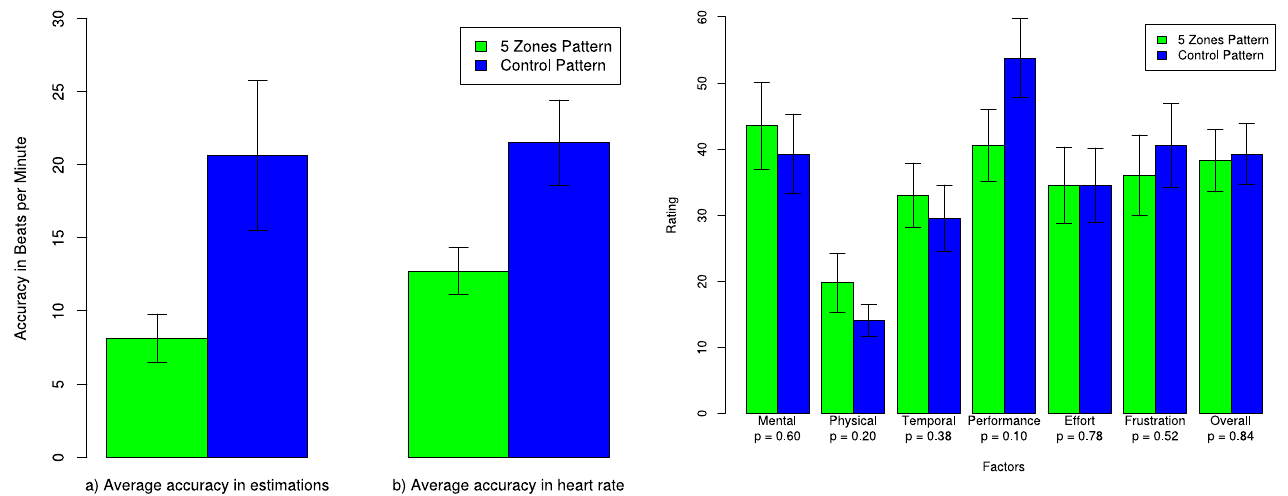
Figure 4. Average accuracy in estimations(a) andin keepingthe optimalheart rate (b) comparedforbothconditions.Lowervalues are better. Errorbars showstandarderror.